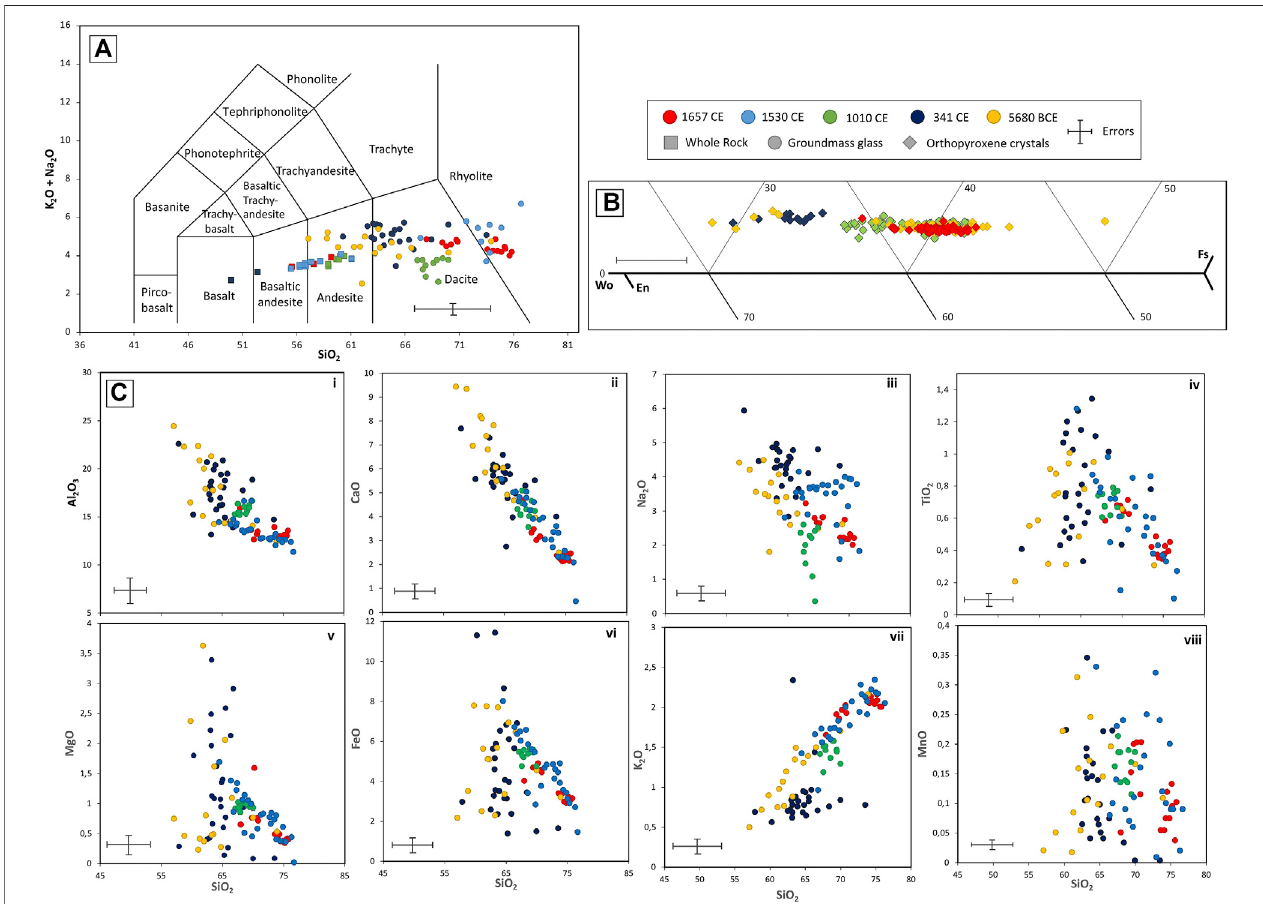
FIGURE 6 | (A) Total alkali-silica diagram (Streckeisen et al., 2002) for ICP-MS whole rock data and groundmass glass compositions from the range of eruptions studied.Whole rockdataisbasaltic toandesitic incompositionand thegroundmassglass ismoreevolved, rangingfrom andesitic torhyolitic. Theoldereruptions,5680 Cal.BCE.and ∼ 341Cal.CEshowlessevolvedcompositionsincomparisontotheyoungereruptions,1010Cal.CE.and1657Cal.CE. (B) Ternarydiagramshowingthe proportions of pyroxene endmembers Wollastonite (Wo), Enstatite (En) and Forsterite (Fo). The orthopyroxenes studied are enstatite rich and show little compositional variation between eruptions. (C) Groundmass glass SiO2 variation diagrams for (i) Al 2 O 3 , (ii) CaO, (iii) Na 2 O, (iv) TiO 2 , (v) MgO, (vi) FeO, (vii) K 2 O and (viii) MnO for the eruptions studied. The 1530 Cal. CE eruption is also included to provide a more complete picture of La Soufrière de Guadeloupe (Boudon et al., 2008; Pichavant et al., 2018). All these glass compositions were determined to be in equilibrium with the nearest crystal, with the K D (Mg/Fe) melt /(Mg/Fe) mineral between 0.23 – 0.35, the accepted equilibrium values for melt-pyroxene crystals (Putirka, 2008).